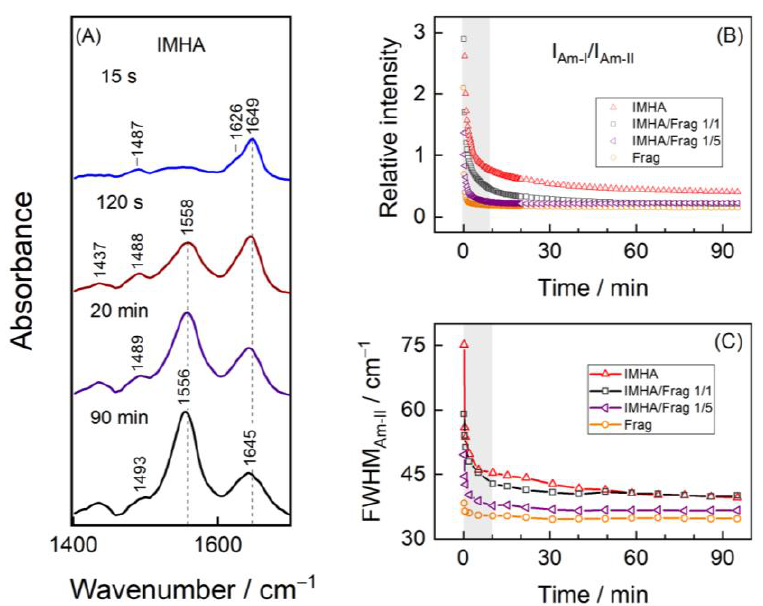
Figure 4. ( A ) SEIRAS spectra of IMHA SAM in ethanol adsorption solution at different incubation times. ( B ) The temporal evolution of the Am-I/Am-II intensity ratio of SAMs composed of IMHA, Frag, and their mixtures (1/1 and 1/5). ( C ) FWHM of Am-II spectral mode of different composition SAMs.